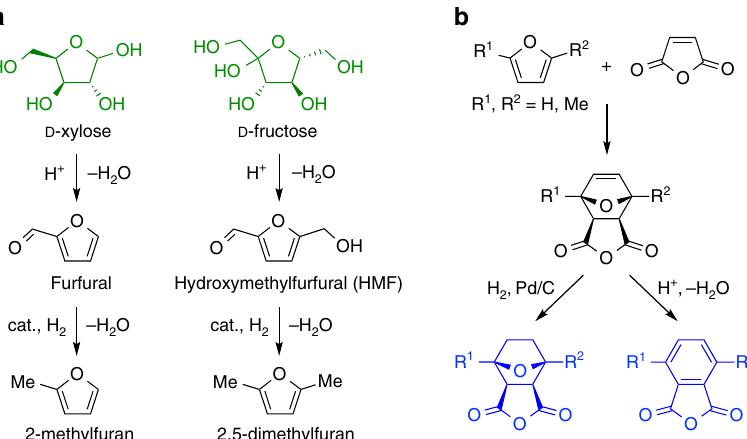
Fig. 1 Monomer synthesis. a Catalytic conversion of D -xylose and D -fructose into 2-methylfuran and 2,5-dimethylfuran, respectively. b Transformation of substituted furan derivatives into tricyclic (left) and phthalic (right) anhydride